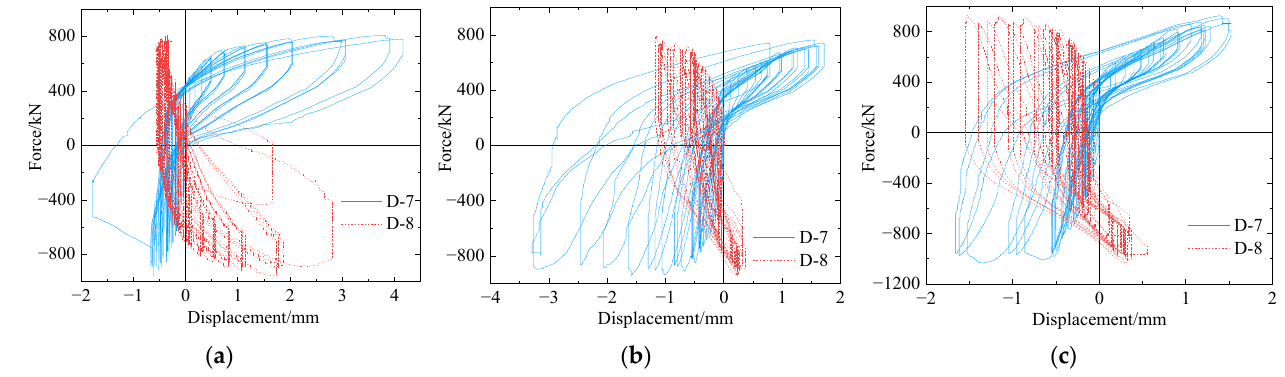
Figure 18. Oblique deformation curves of specimens: ( a ) LSW; ( b ) LAPC-1; and ( c ) LAPC-2.